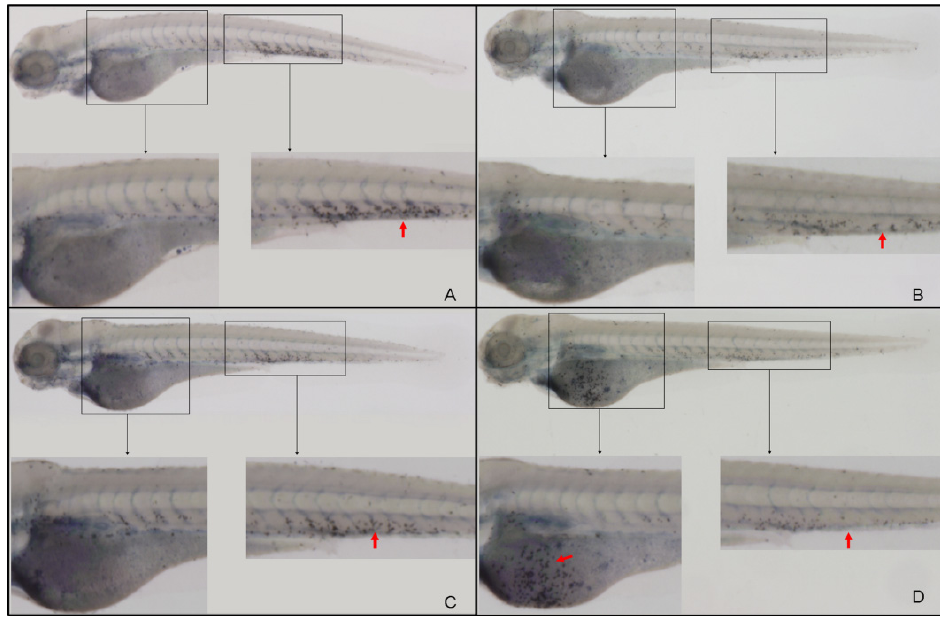
Figure 3. Representative pictures of SB labeling of neutrophils at 3 dpf. ( A ) Normal controls; ( B ) larvae immersed in LPS (0.5 mg/mL); ( C ) PBS-injected negative controls; and ( D ) larvae with LPS (0.5 mg/mL) injected into the yolk ( n = 34).